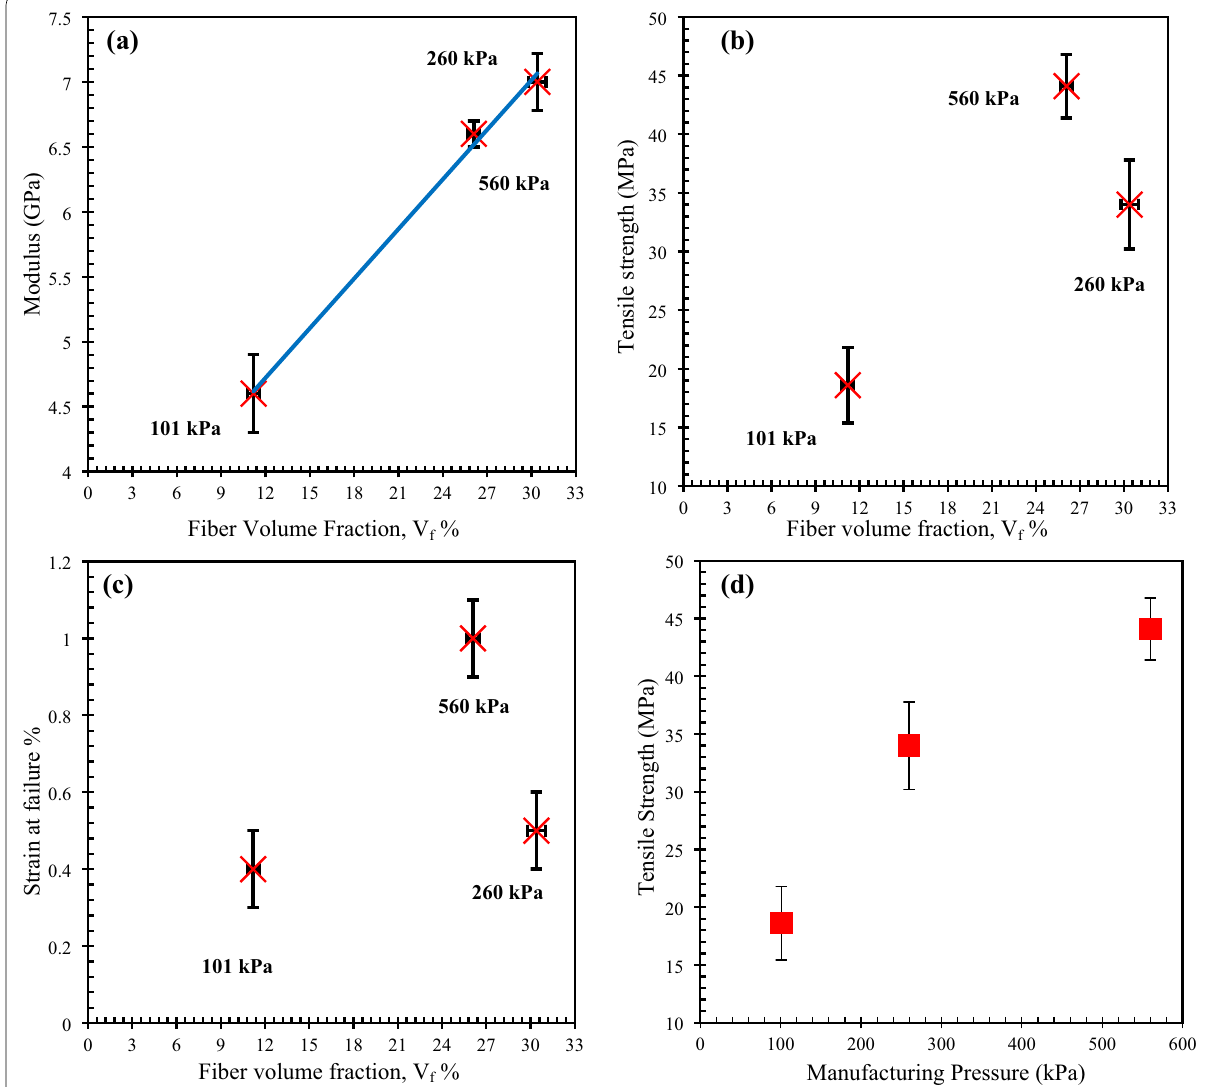
Fig. 9 Relationship between a tensile modulus and V f ; b tensile strength and V f ; c strain at failure, and V f ; d tensile strength and consolidation pressure—for cattail